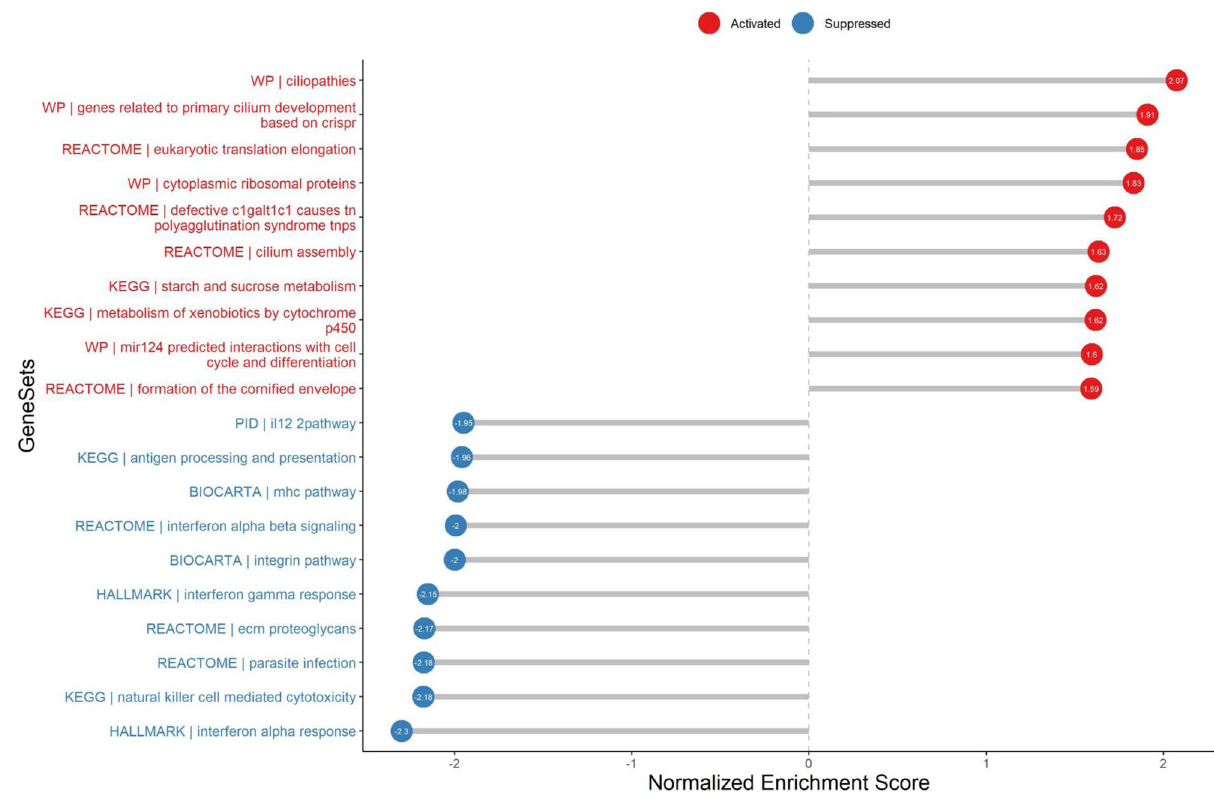
Figure 1. GSEA analys in CPAM parietal tissue vs CPAM lesion